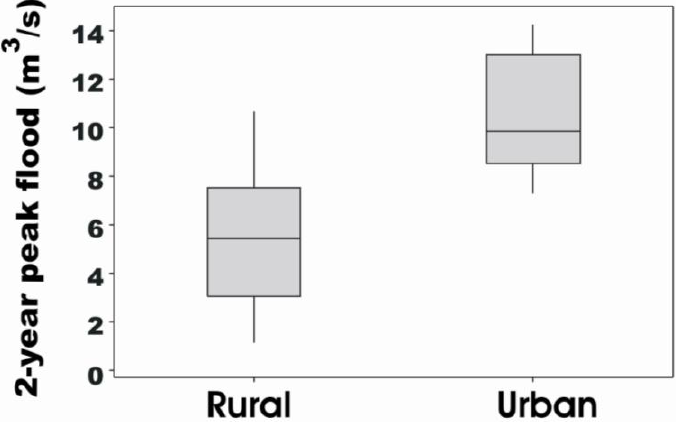
Figure 4. A boxplot (box represents, 25th, 50th, and 75th percentiles) comparison of urban and rural 2 year peak streamflows for 10 small watersheds (1 mi 2 or 2.6 km 2 ) in 10 states (AL, DE, FL, GA, KY, LA, NC, SC, TN, TX) within the southern U.S. (using the National Streamflow Statistics Program (Turnipseed and Ries, 2007 )). Simulated watershed impervious area was 25%